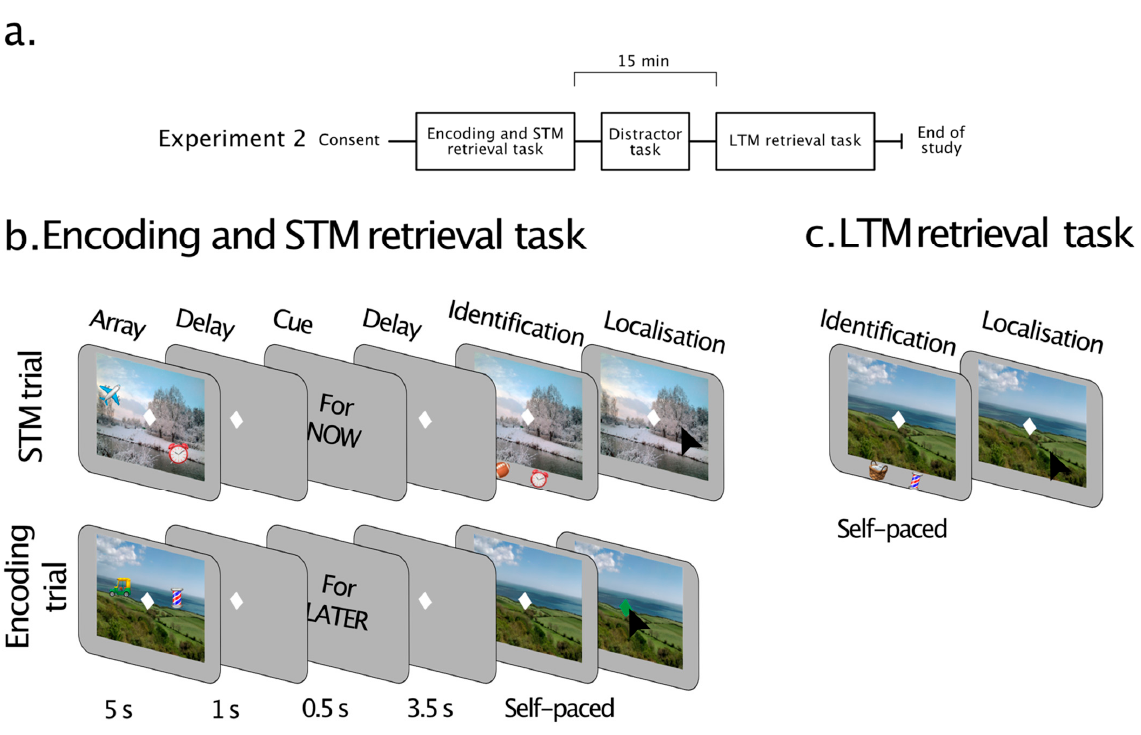
Figure 4. ( a ) Timeline for Experiment 2. All participants performed the same distractor task. ( b